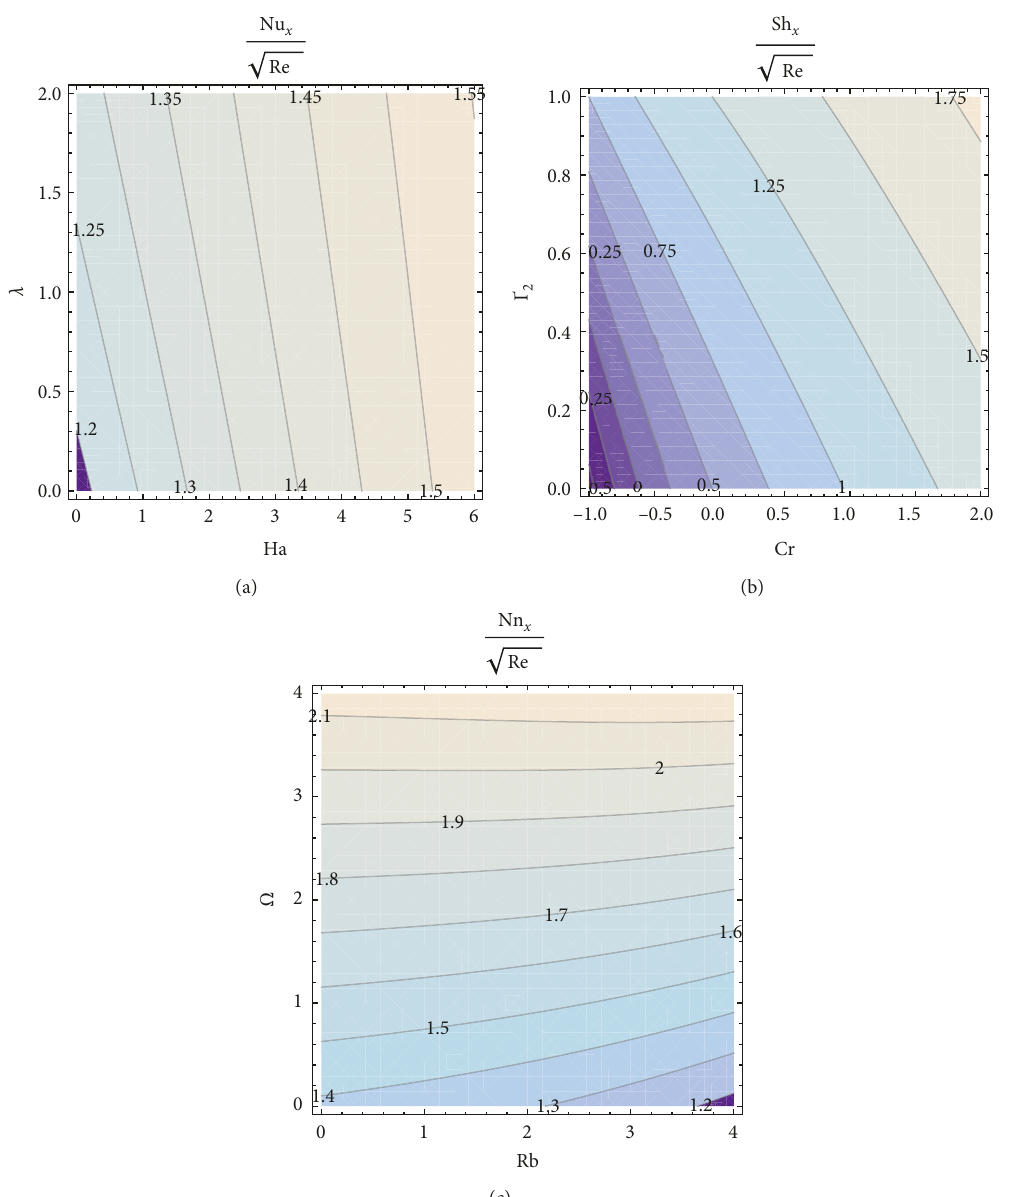
Figure 8: (a) “Nusselt number” for Ha and λ , (b) “Sherwood number” for Γ